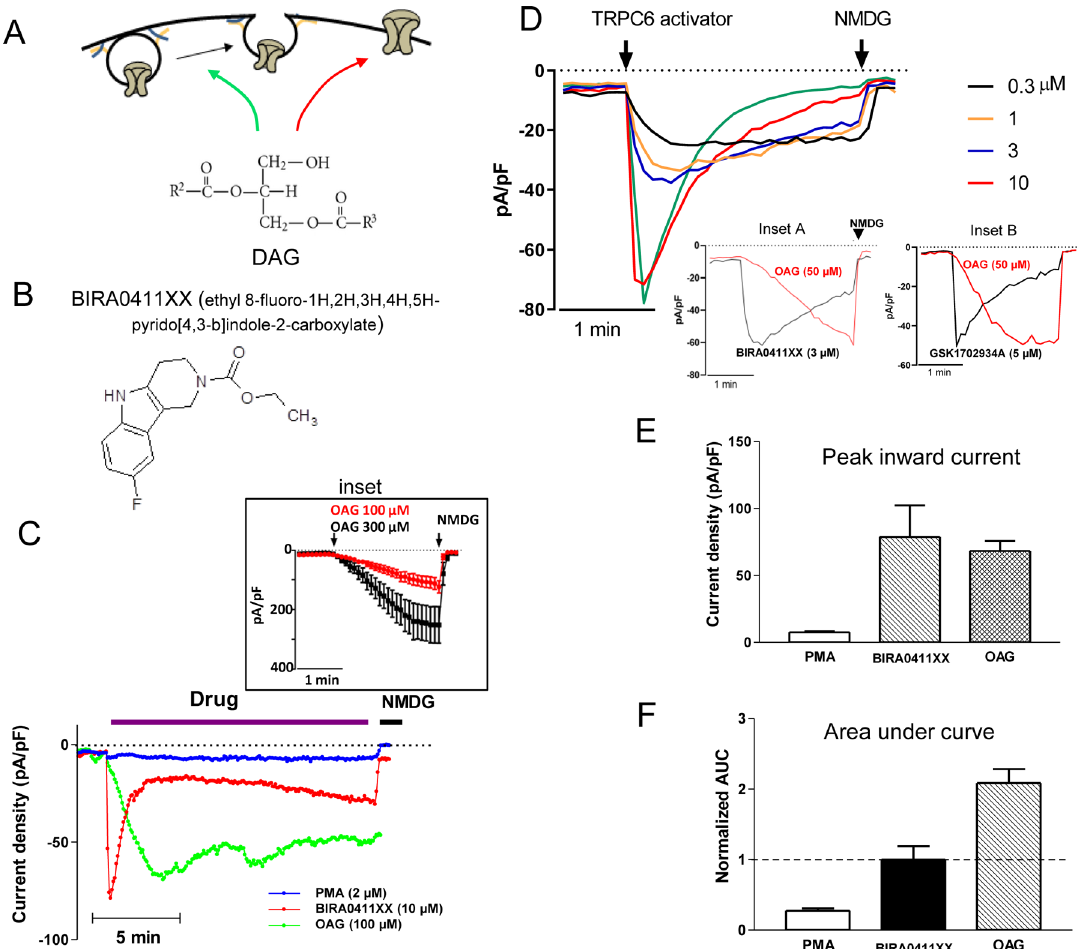
Fig 1. Diacylglycerol (DAG) stimulates TRPC6 exocytosis as well as directly activates the channel. (A) Diagram illustrating dual mechanisms of activation of TRPC6 by DAG. (B) Chemical structure of TRPC6 channel activator BIRA0411XX. (C) Time course of TRPC6 activation by DAG and by BIRA0411XX. TRPC6-mediated currents were recorded in whole-cell mode from HEK cells expressing recombinant TRPC6. After baseline recording, membrane permeable DAG analog (oleoly-acetyl-glycerol, OAG), BIRA0411XX or PMA (phorbol myristate acetate) was applied extracellularly. NMDG ( N -Methyl-D-glucamine) was added at the end of experiment. Inset shows dose-dependent activation of TRPC6 by OAG (100 and 300 μ M). Shown are representative tracings of current density (pA/pF) at -100 mV. Inset shows dose-dependent relationship of OAG activation of TRPC6. (D) Dose-response activation of TRPC6 current by BIRA0411XX. Inset A and B shows representative time course of activation by BIRA0411XX and by GSK1702934A, respectively, versus 100 μ M OAG. (E) Bar graph shows mean ± SEM of peak inward current density from multiple experiments as in panel C. (F) Mean ± SEM of area under curve (AUC) from multiple experiments as in panel C. Data are normalized relative to